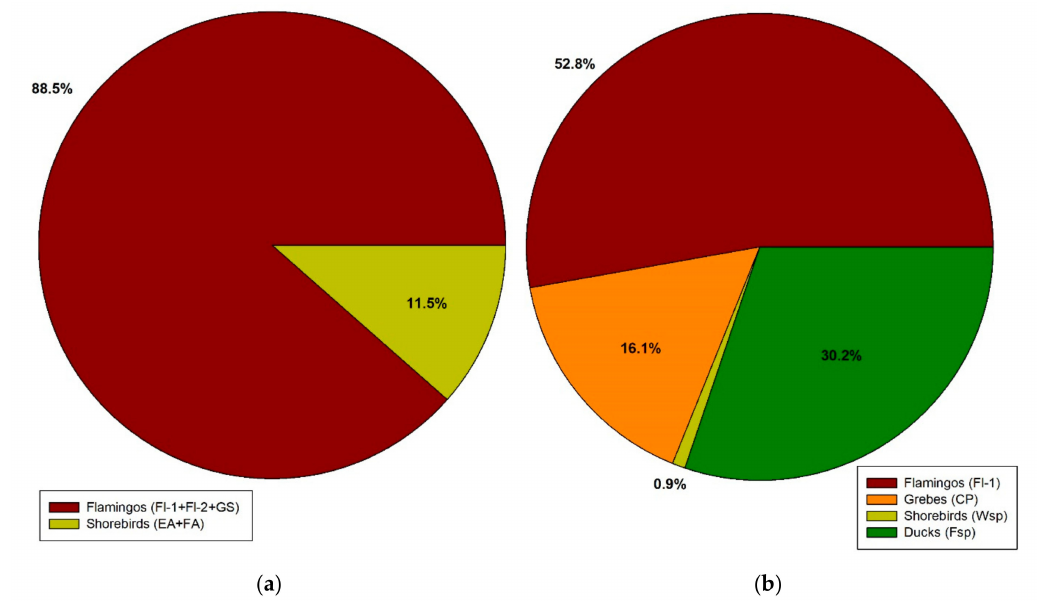
Figure 2. Relative abundance of cestodes with different avian final hosts found in Artemia intermediate hosts in relation. ( a ) A. franciscana in the north of Chile (Salar de Atacama lagoons); ( b ) A. persimilis in the south of Chile (Amarga lagoon and Cisnes lagoon, combining data from this study and from